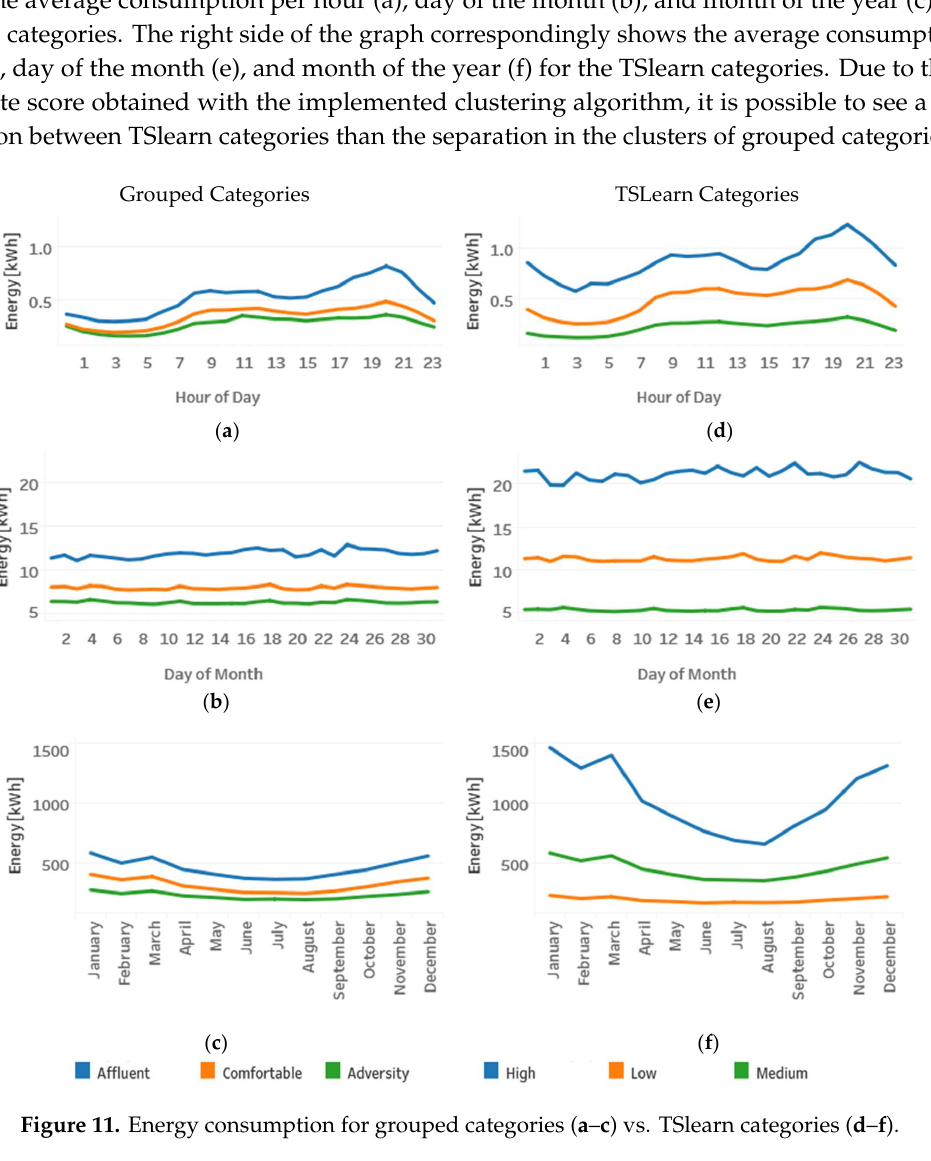
Table 4. Result summary of the k-means clustering algorithm.